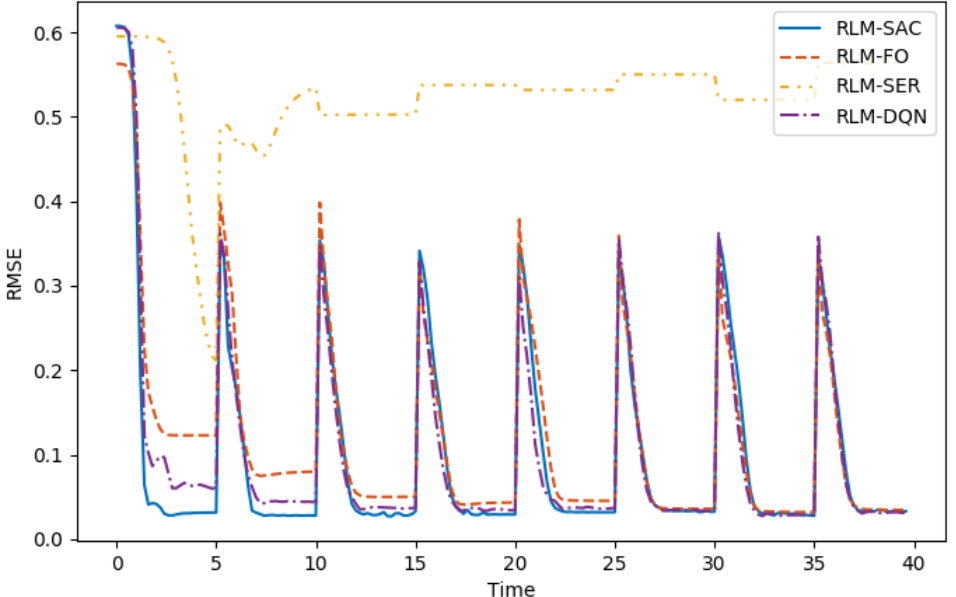
Figure 7. RMSE of radius factors generated by different RL realizations. The flight conditions in test trajectories change every 5 s, and at this time, the airfoil is expected to morph to a new reference